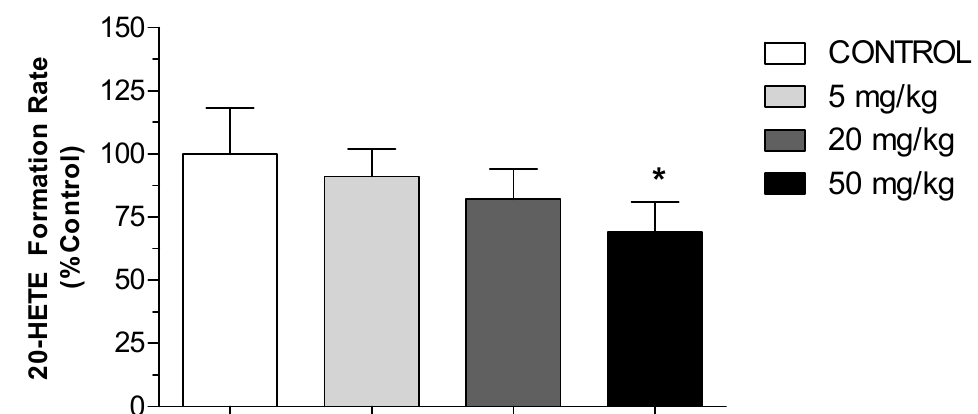
Figure 4. Effect of HON on the rate of 20-HETE formation in rat kidney microsomes, expressed as the percentage of the control group. Rat kidney microsomes obtained from SHR ( n = 8/group) treated intraperitoneally daily for 3 weeks with HON at different doses. All groups were compared using one-way ANOVA followed by multiple comparisons. * Significant difference from control with p < 0.05.